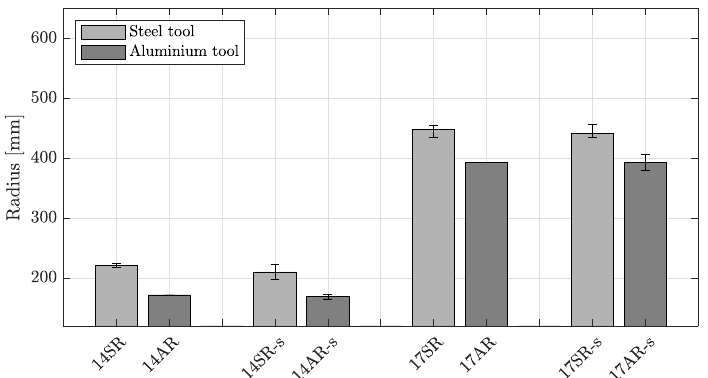
Figure 11. Specimens manufactured on the aluminum tool show significantly smaller radii compared to the specimen manufactured on the steel